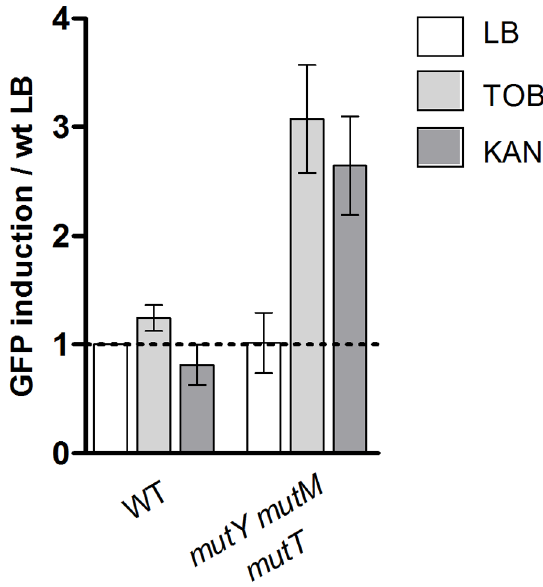
Figure 3. Oxidized guanine incorporation after tobramycin treatment induces SOS in the E. coli base excision repair deficient mutant. Histogram bars show the ratio of GFP fluorescence in the presence of antibiotic over fluorescence of the wild type strain grown in LB and thus reflect the induction of SOS. TOB: tobramycin 0.1 m g/ml. KAN: kanamycin 0.2 m g/ml. WT is E. coli is BER proficient.